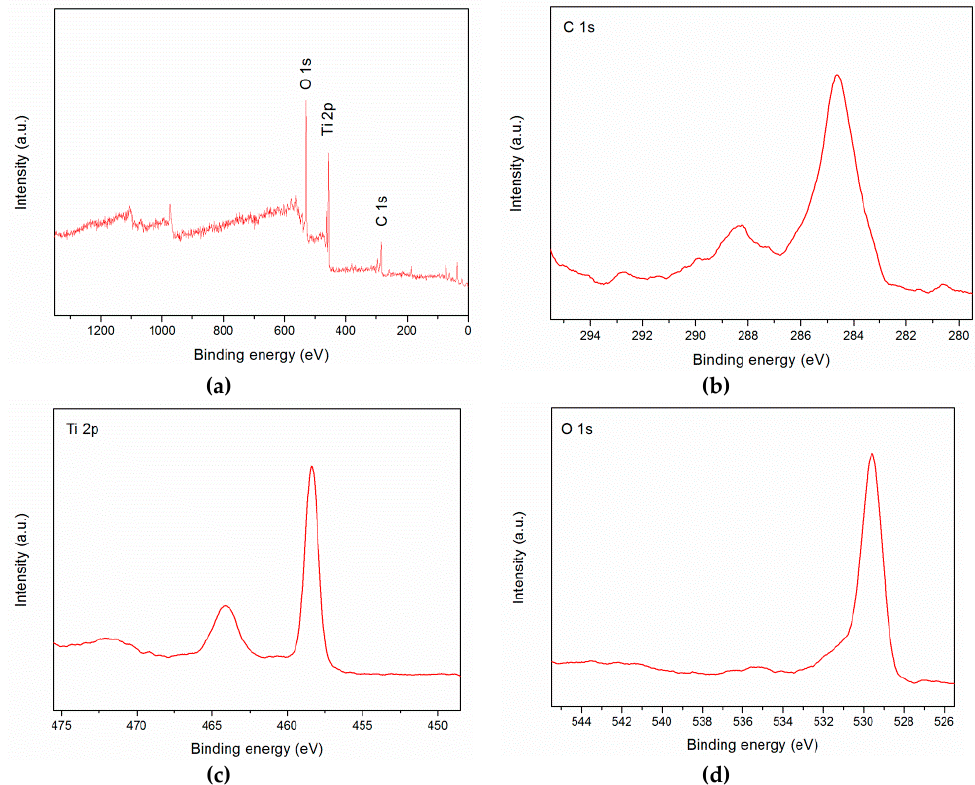
Figure 2. X-ray photoelectron spectroscopy (XPS) analysis of the synthesized nanoparticles. ( a ) General XPS spectrum; ( b ) de-convoluted XPS spectrum of C 1s; ( c ) de-convoluted XPS spectrum of Ti 2p; and ( d ) de-convoluted XPS spectrum of O 1s.